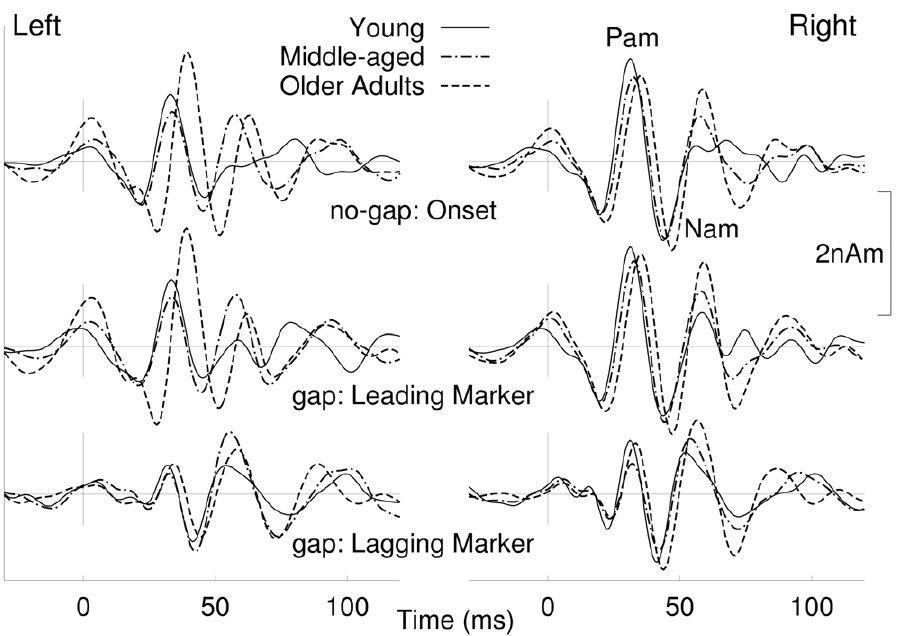
Figure 7. Overlay of grand averaged responses to the onset of no-gap stimuli for the three age groups (top traces). The most prominent positive and negative going waves are labeled in the right hemispheric responses as Pa m and Na m according to the nomenclature used for middle latency responses. Grand averaged responses to the onset of the leading markers of gap stimuli are shown in the middle traces and responses to the lagging markers obtained from the difference waves in the bottom traces.